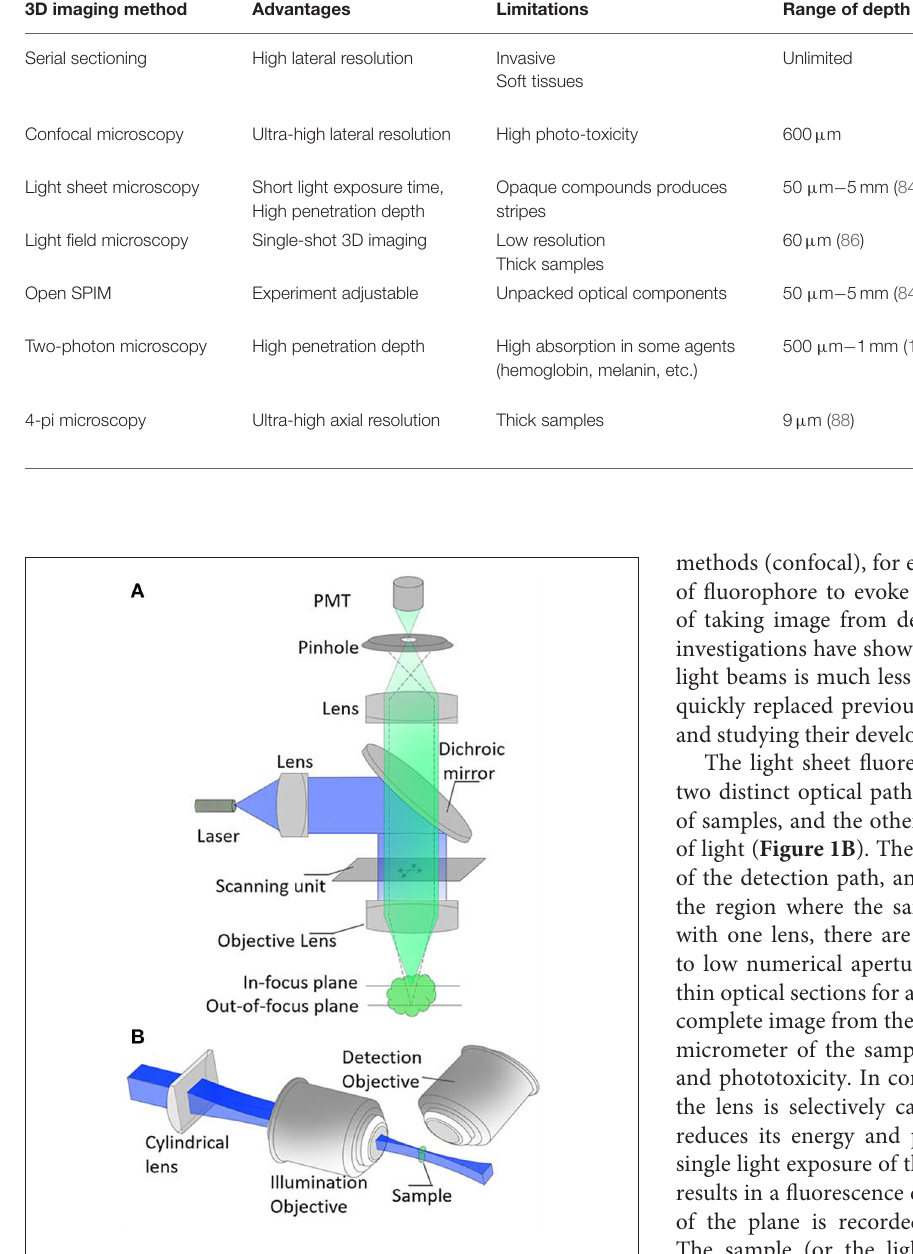
FIGURE 1 | Optical setup of (A) confocal microscopy and, (B) light-sheet microscopy. The pinhole element in (A) helps to remove out-of-focus signals so that a high resolution image could be retrieved. The key element of (B) is the cylindrical lens. This helps to achieve a very thin sheet of light at the focus of the illumination objective. Blue and green represent excitation and fluorescence signals,